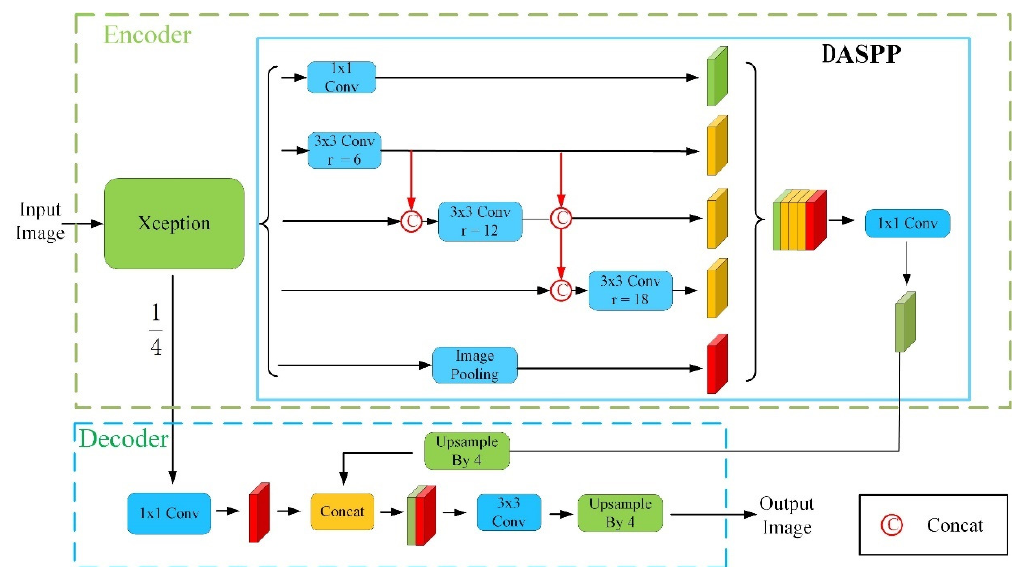
Figure 5. MC-DM network architecture.